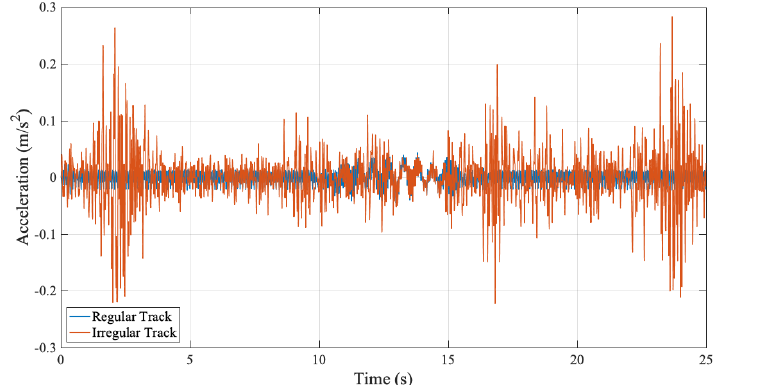
Figure 10. Accelerations recorded on the bogie for a speed of 20 km/h ignoring and considering track